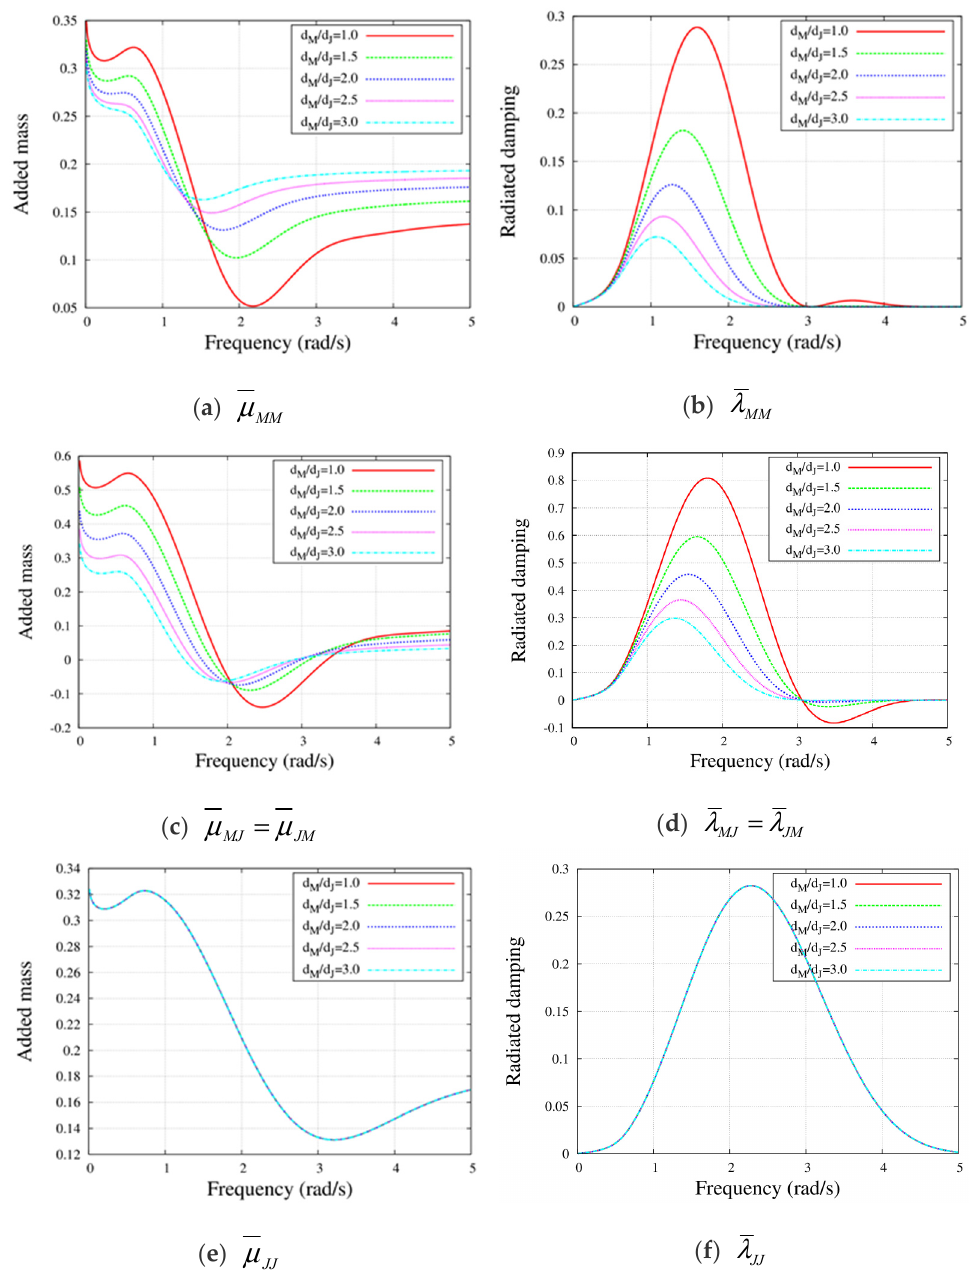
Figure 8. The hydrodynamic coefficients of the moonpool platform and the float. and finally stabilized. Furthermore, the frequency range was 0 ~ 1(rad/s) ω= —the size of the added mass changed very little and decreased with the ω= increase in the draught. When the frequency range was 0 ~ 3(rad/s) , the additional mass first decreased and then increased, and the peak value increased with the increase 3 ~ 5(rad/s) ω= the additional mass tended to be stable and changed very little with the increase in the radius. The radiation damping first increased and then decreased with the increase in the frequency, and there were two peaks of magnitude. The peak value decreased with the increase in the radius, while the frequency of the peak point also showed a decreasing trend. In conclusion, a comparison between Figures 7 and 8e,f shows that the size of the moonpool had no effect on the addi- tional mass and radiation damping when the radiation generated by the javelin float was applied to the moonpool itself, and the short, thick moonpool platform had a large radia- tion damping force. 3.1.2. The Motion Response The results of the response amplitude operator were given by Equation (44), which could be used to verify the influence of the geometrical parameter of the moonpool and javelin damping coefficients on the wave energy buoy motion. As can be seen from Figure 9, the overall trend is the same regardless of whether the radius of the moon pool platform or the draft changes, and there are one or two peaks. When a given moonpool platform drew water, as the radius increased, the value of the first peak point increased, while the frequency corresponding to the peak point decreased. The change law of the second peak point was the same. When the radius of a given lunar pool platform was calculated, the value of the first peak point increased with the increase